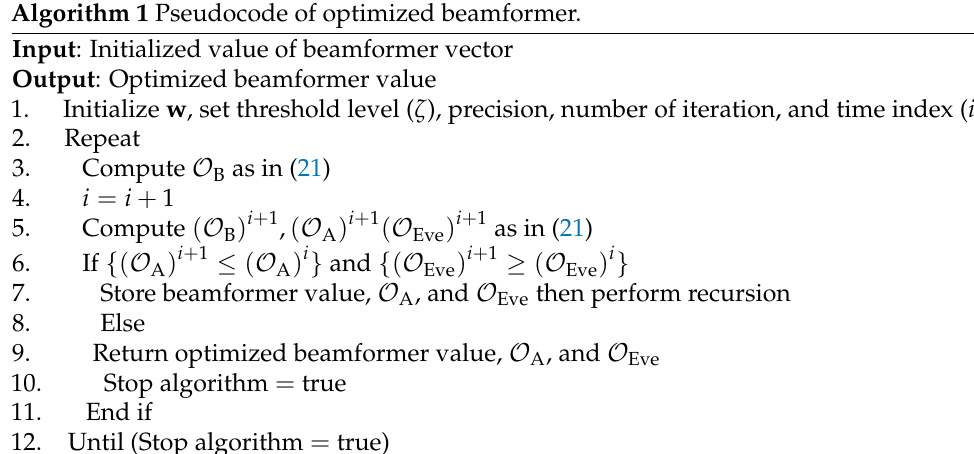
Algorithm 1 Pseudocode of optimized